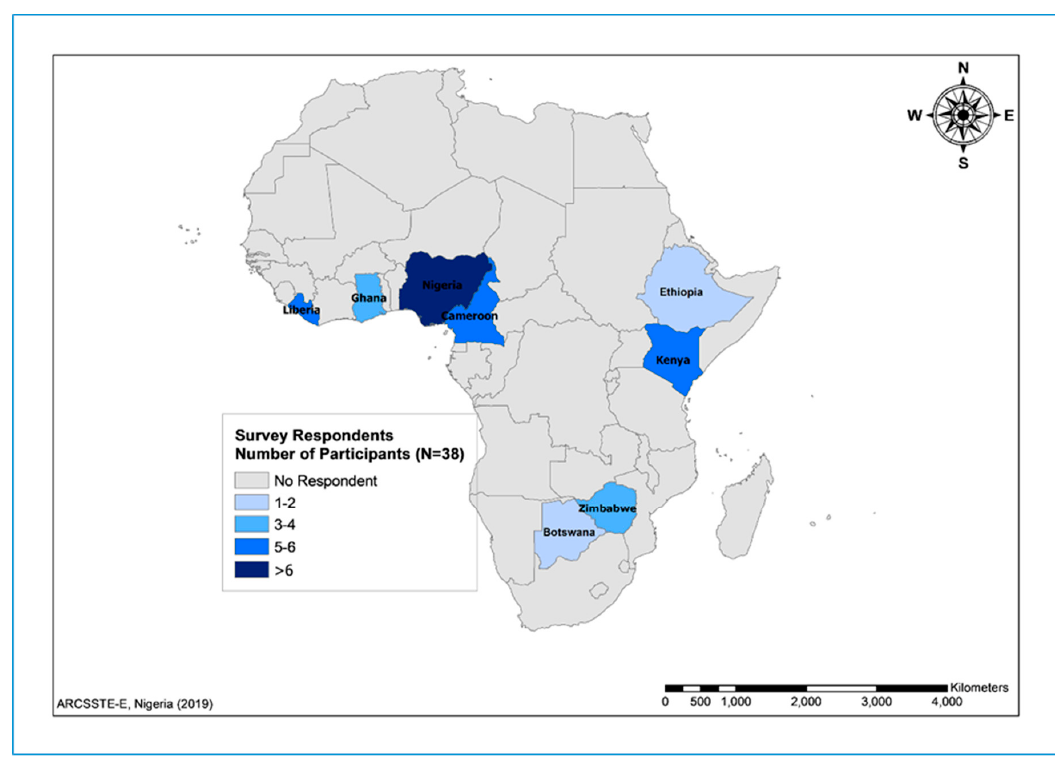
Figure 5. Number of ARCSSTE ‐ E survey respondents per country. There were 38 participants from eight African countries.